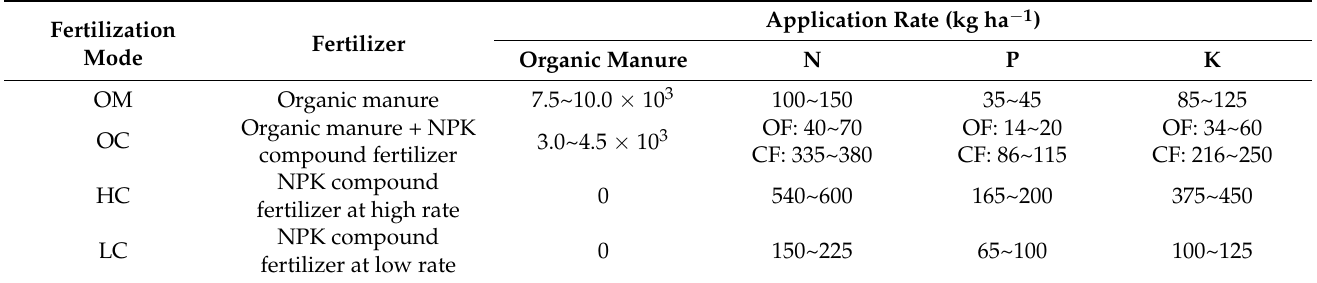
Table 1. Fertilizer applied rates in different fertilization